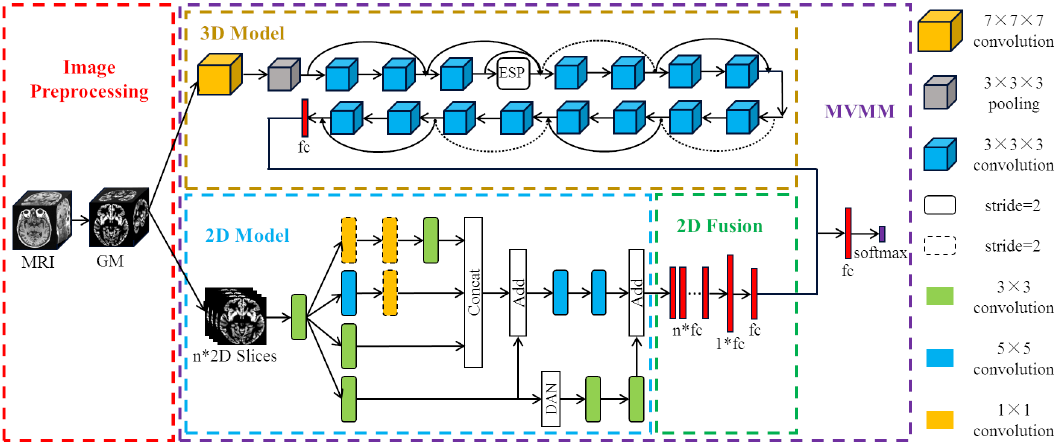
Figure 1. Multi-view based multi-model learning framework.